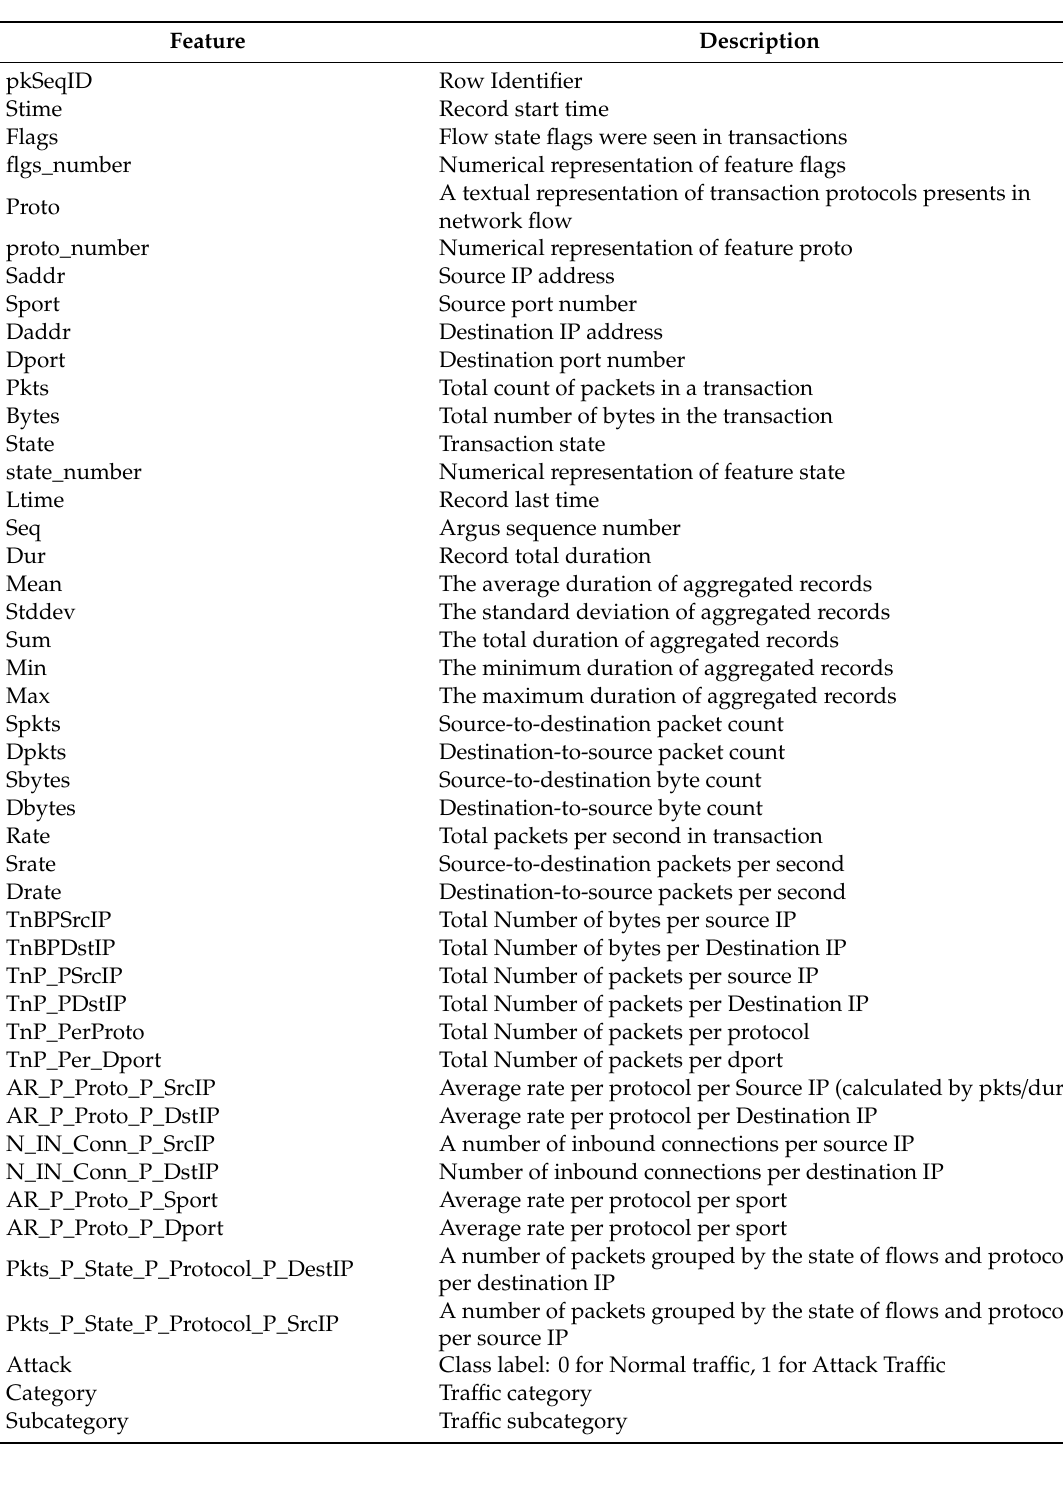
Table 4. Features for IoT